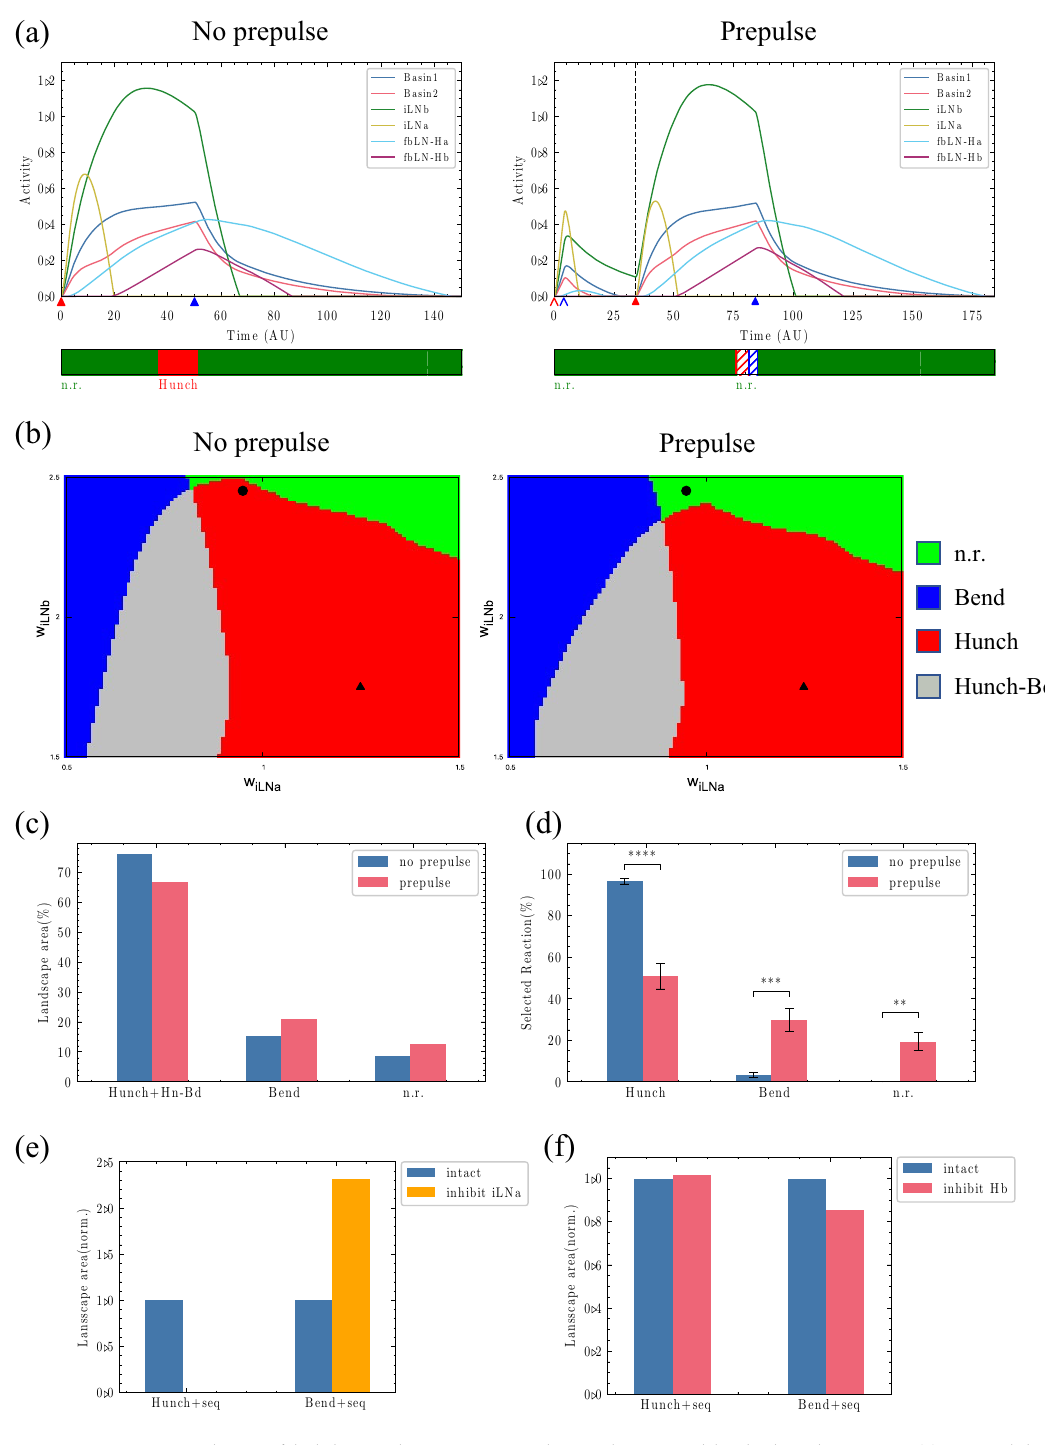
Figure 2. Reproduction of the behavioural experiment using the neural circuit model with adjusted parameters. ( a ) Temporal changes = 0.95, w = 2.45 in the activity of each neuron at the black dot ( w iLNa ), where the suppression of the startle response occurs iLNb due to PPI in ( b ). Left: Without a prepulse; Right: With a prepulse. The vertical dashed black line indicates the time of the pulse input. The thin arrow head pointing to the horizontal axis indicates the prepulse timing, and the thick arrow head indicates the pulse timing. The red and blue colours indicate the onset and offset times, respectively. The colours in the band below each graph indicate the behaviour at the corresponding time. Green: n.r., red: hunch, blue: bend. The behaviours shown with diagonal lines are classified as − w n.r. because their durations are shorter than the cut-off time (10 time units). ( b ) Behavioural landscape in the w iLNb iLNa space. Left: Without a prepulse. Right: With a prepulse. ( c ) Changes in the percentage of each behaviour in the behavioural landscape due to prepulses. The Hunch + Hn-Bd indicates the sum of the hunch and the hunch-bend sequence because we counted the first selected behaviour in our experimental procedure. The bend-hunch sequence did not occur. ( d ) Experimental results of behavioural change due to prepulses. ( e ) iLNa inhibition results obtained with the model used in this study. The Hunch (Bend) + seq includes the Hunch (Bend) and both sequences, as in Jovanic et al . 32 ( f ) Hb inhibition results obtained with the model used in this